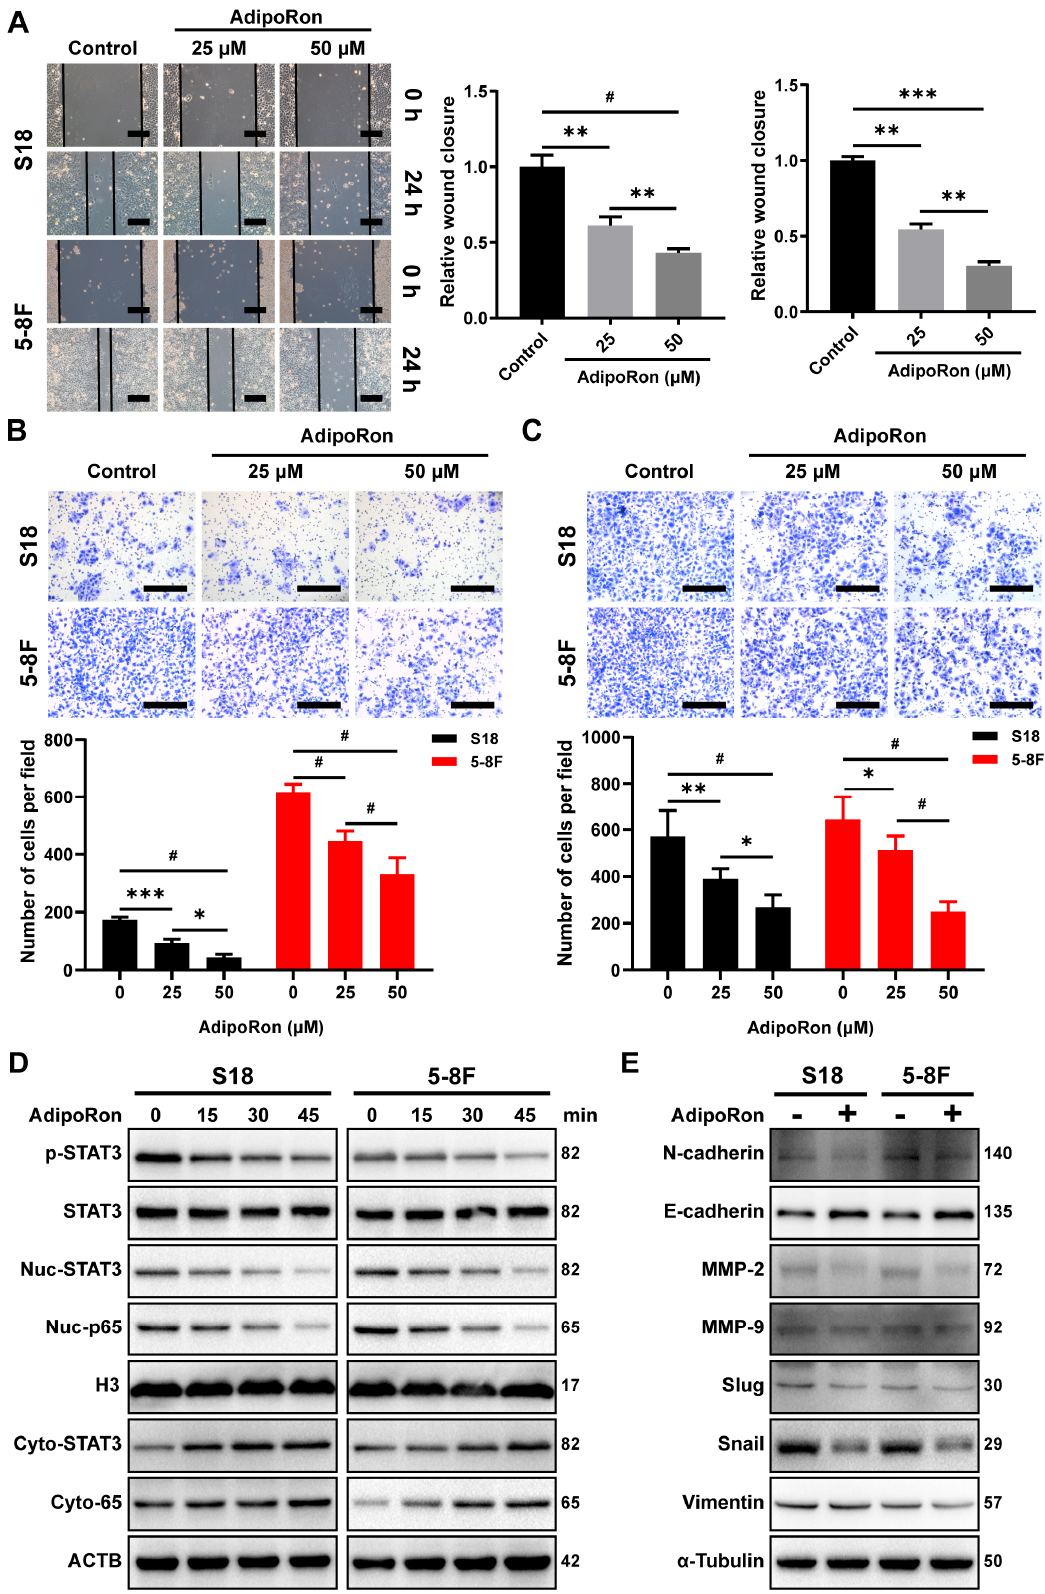
Figure 6. AdipoRon inhibits NPC cell migration and invasion in vitro. ( A ) Wound healing assay of S18 and 5-8F cells treated with AdipoRon (0, 25, or 50 μ M) for 24 h. Scale bar: 200 μ m. Graphs show the relative wound closure. Transwell ( B ) invasion and ( C ) migration of S18, 5-8F cells after treat- ment with AdipoRon (0, 25, or 50 μ M) for 24 h. Scale bar: 200 μ m. Graphs show the relative number